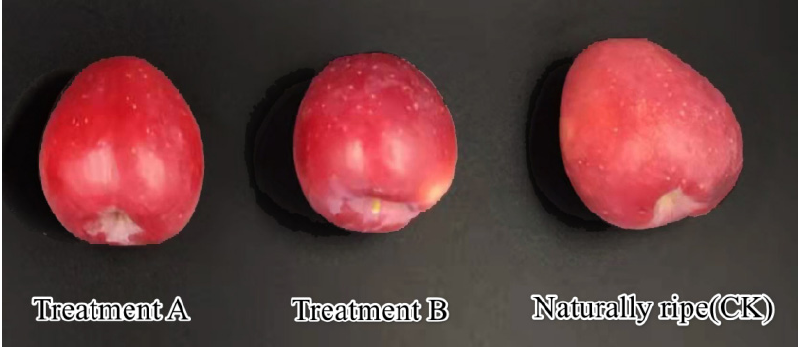
Figure 1. Fruit appearances at the ripening stage under different treatment conditions.